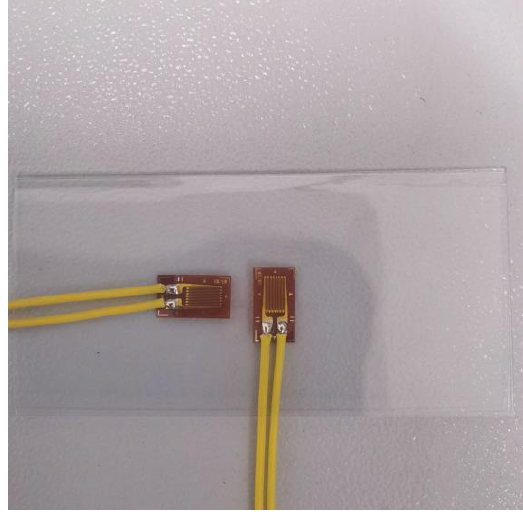
Figure 29. Half-bridge connection. Table 6. Comparison of test and simulation results